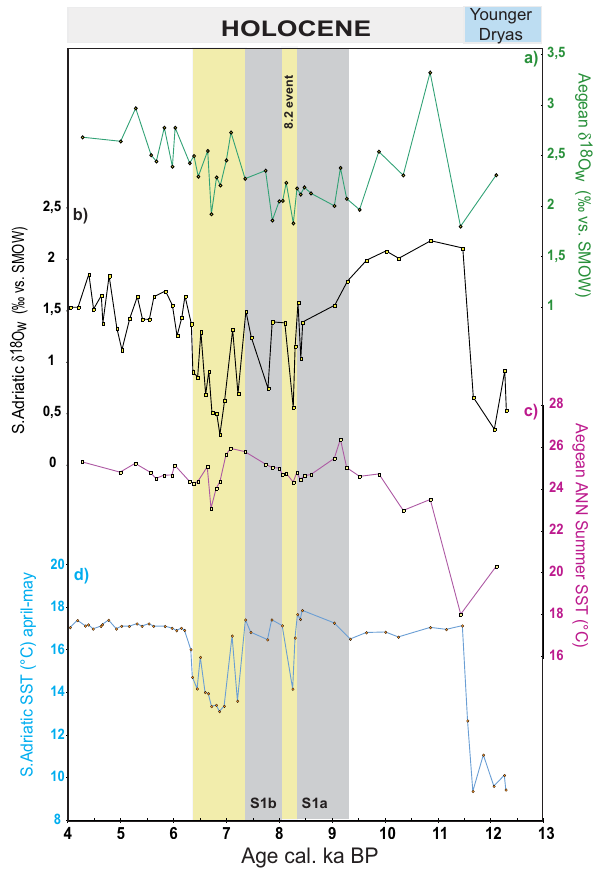
Fig. 4. Comparison between the South Adriatic Sea (this study) and the Aegean Sea climatic record from core LC-21 (Rohling et al., 2002; Marino et al., 2009) vs. age (cal.kaBP). (a) Aegean Sea δ 18 O w record. (b) South Adriatic δ 18 O w record. (c) Artifi- cial neural networks (ANN) based summer SST estimations in the Aegean Sea. (d) April–May South Adriatic Sea surface temperature by MAT. Gray areas refer to S1a and S1b sapropel deposition and yellow areas to the S1 interruption and post-S1b phase in the South Adriatic